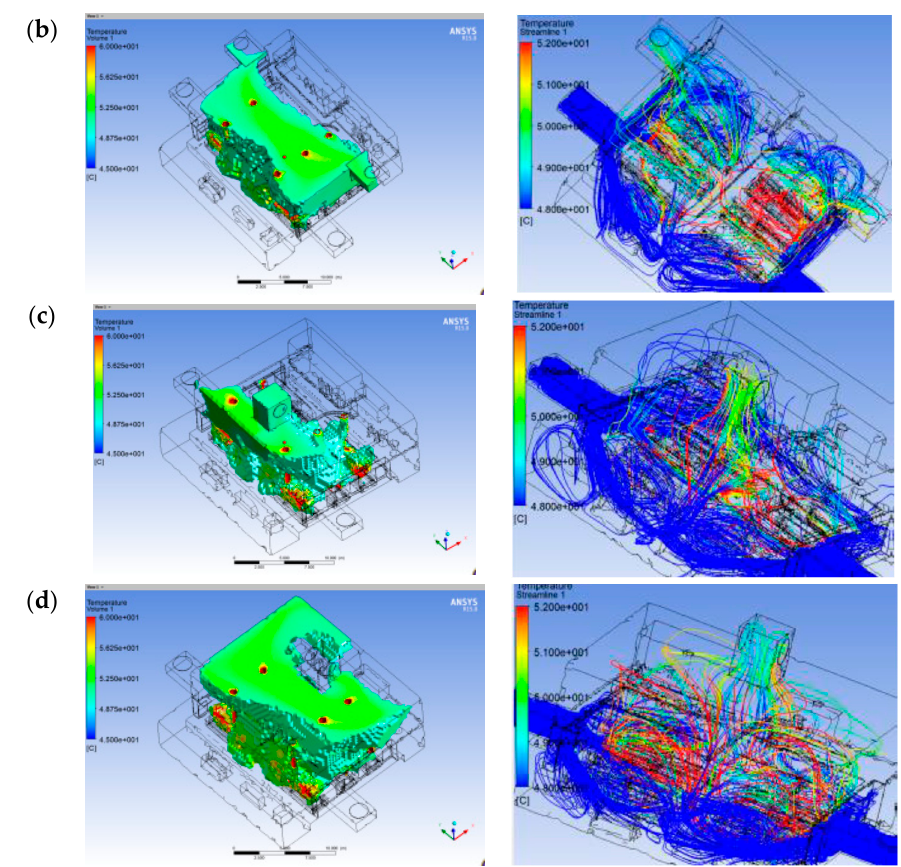
Figure 5. Cloud and streamline maps of the high-temperature distributions (>55 °C). Volume sizes of the four arrangements are: ( a ) 589.1 m 3 , ( b ) 645.3 m 3 , ( c ) 418.7 m 3 , and ( d ) 593.9 m 3 .